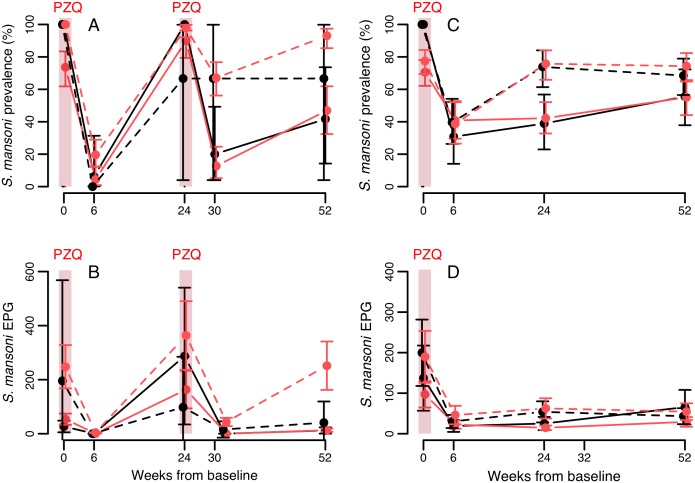
Longitudinal dynamics of S. mansoni in Senegal (A, B) and Niger (C, D), according to co-infection status at baseline.Means from raw data are plotted with 95% confidence intervals. Confidence intervals for prevalence are exact, and for intensity data were calculated using a negative binomial GLM on egg counts including zero counts. Black and red lines indicate baseline single infections and co-infections with S. haematobium respectively. Solid and dashed lines represent the villages of Temeye and Nder in A and B, and Diambala and Namarigoungou in C and D respectively. There is no line for single infections in Nder because all infections in that village were co-infections.